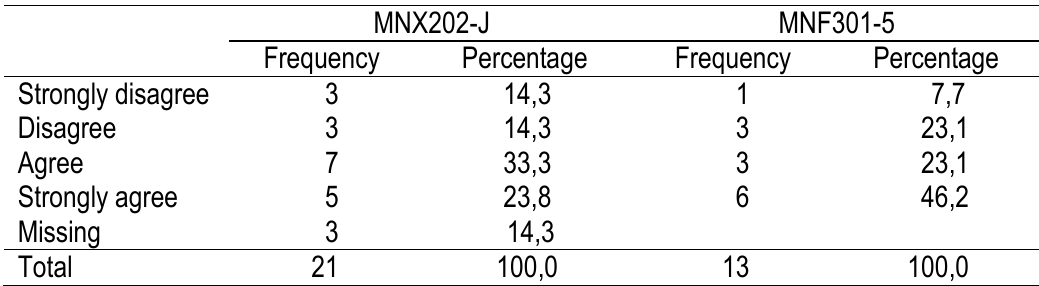
Table B1: I fully understood the instructions regarding the need to submit an assignment